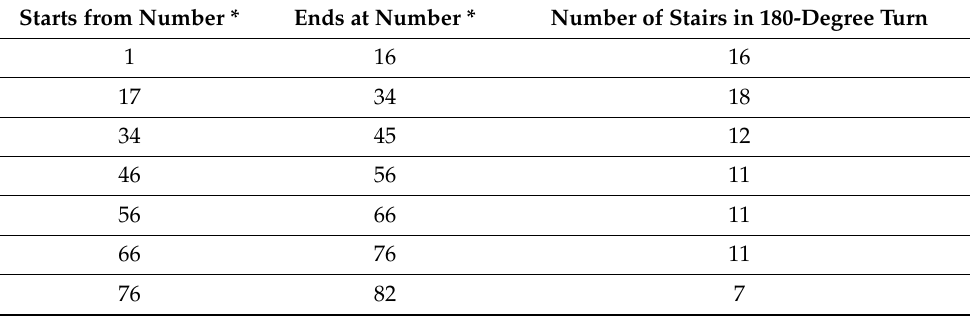
Table 1. Estimated number of stairs in each 180-degree turn.